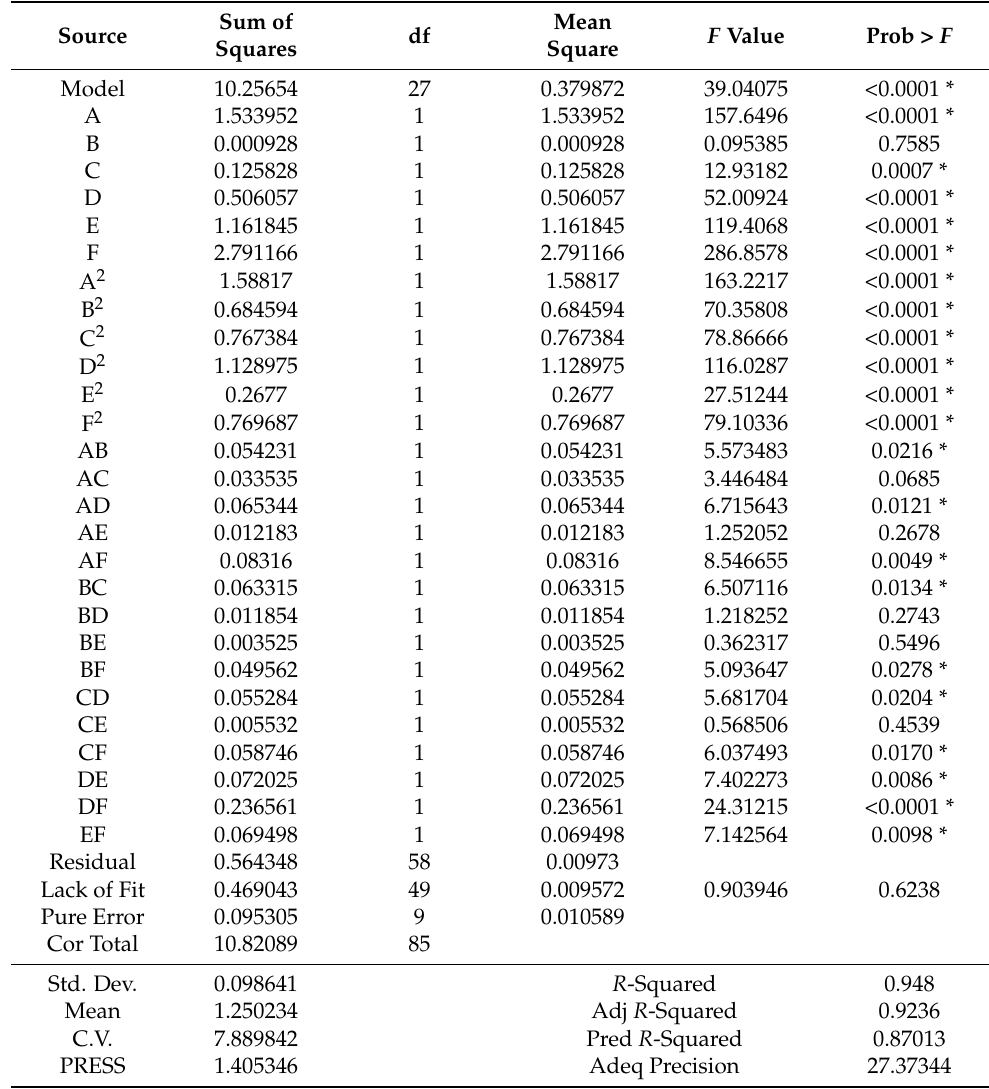
Table 2. Analysis of variance (ANOVA) for Mo reduction in